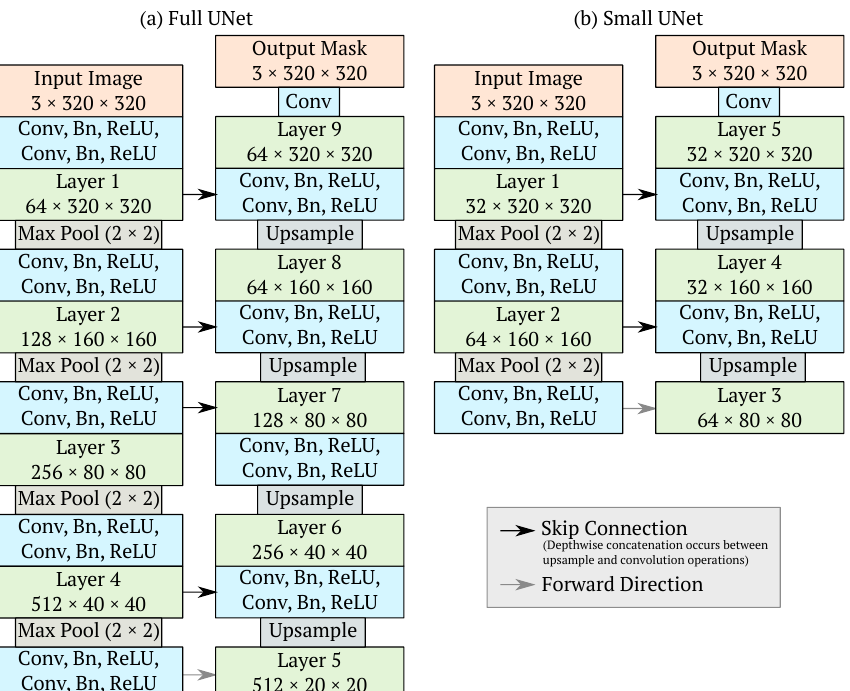
Figure 2. Original UNet architecture shown in ( a ) [22], and smaller UNet architecture shown in ( b ) with only two down-sampling stages. If the Conv operation in the blue boxes is a standard convolution, the networks are referred to as Full and Small UNets. If the Conv operation is a DSC operation, the networks are referred to as Full and Small DSC UNets. If the Conv operation is a LBC operation, the networks are referred to as Full and Small LBC UNets. If the Conv operation is a DSC LBC operation (Figure 1), the networks are referred to as Full and Small DSC LBC